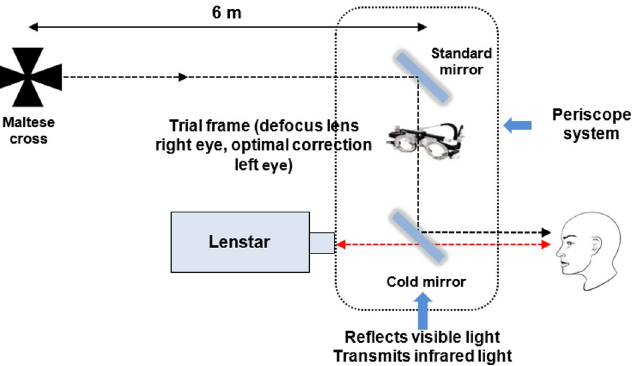
Fig 2. Schematic representation of the experimental set-up for axial length measures. A binocular periscope system was used to allow fixation of the distant target (Maltese cross) while the Lenstar biometer measured axial length.